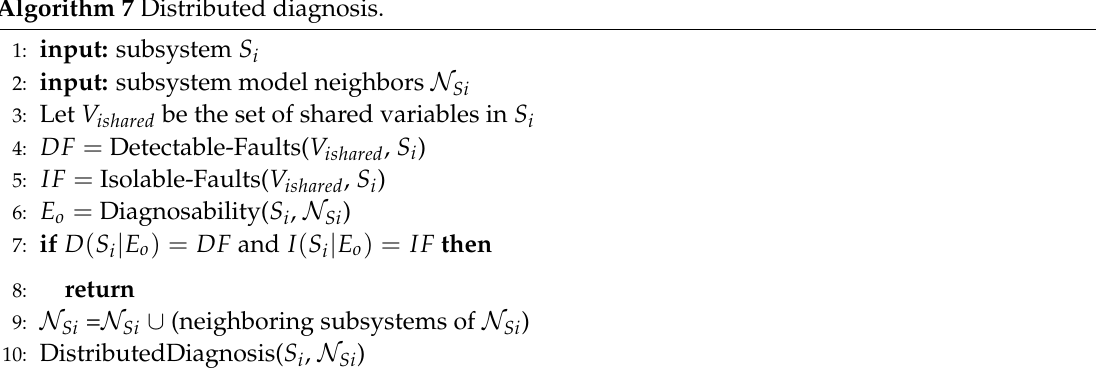
Figure 10. Expanding the search environment to the higher order connected subsystems. Algorithm 7 Distributed